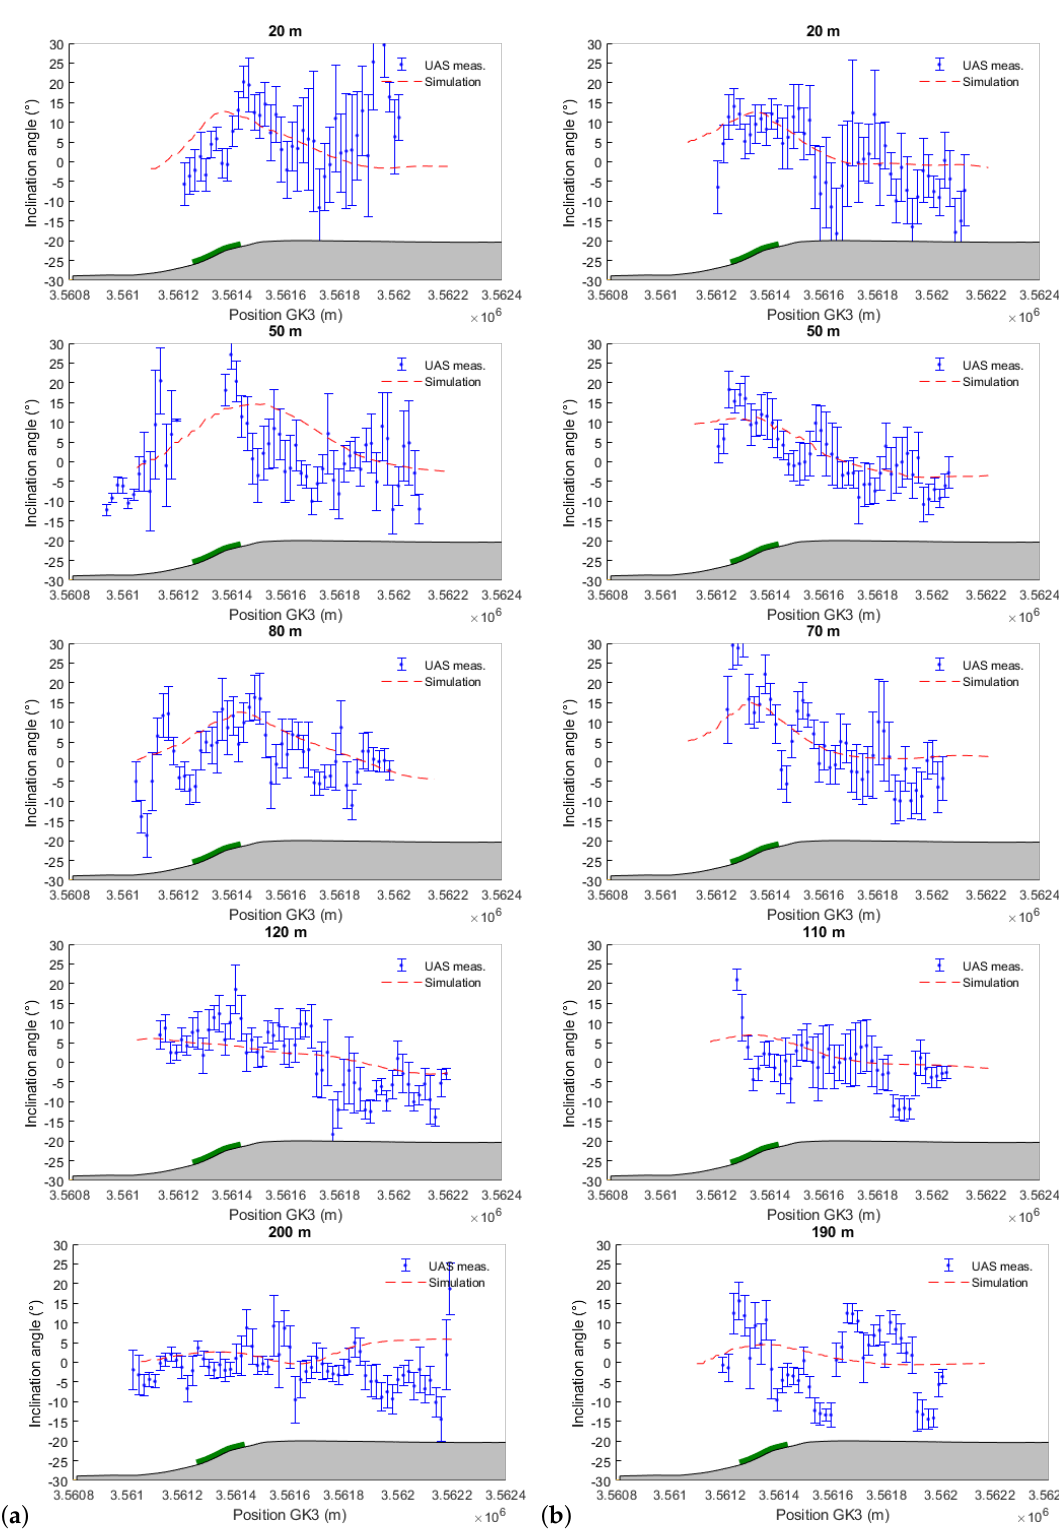
Figure 10. Inclination angles on 21 ( a ) and 22 ( b ) September at different altitudes along the UAS’ flight path. See also Figure